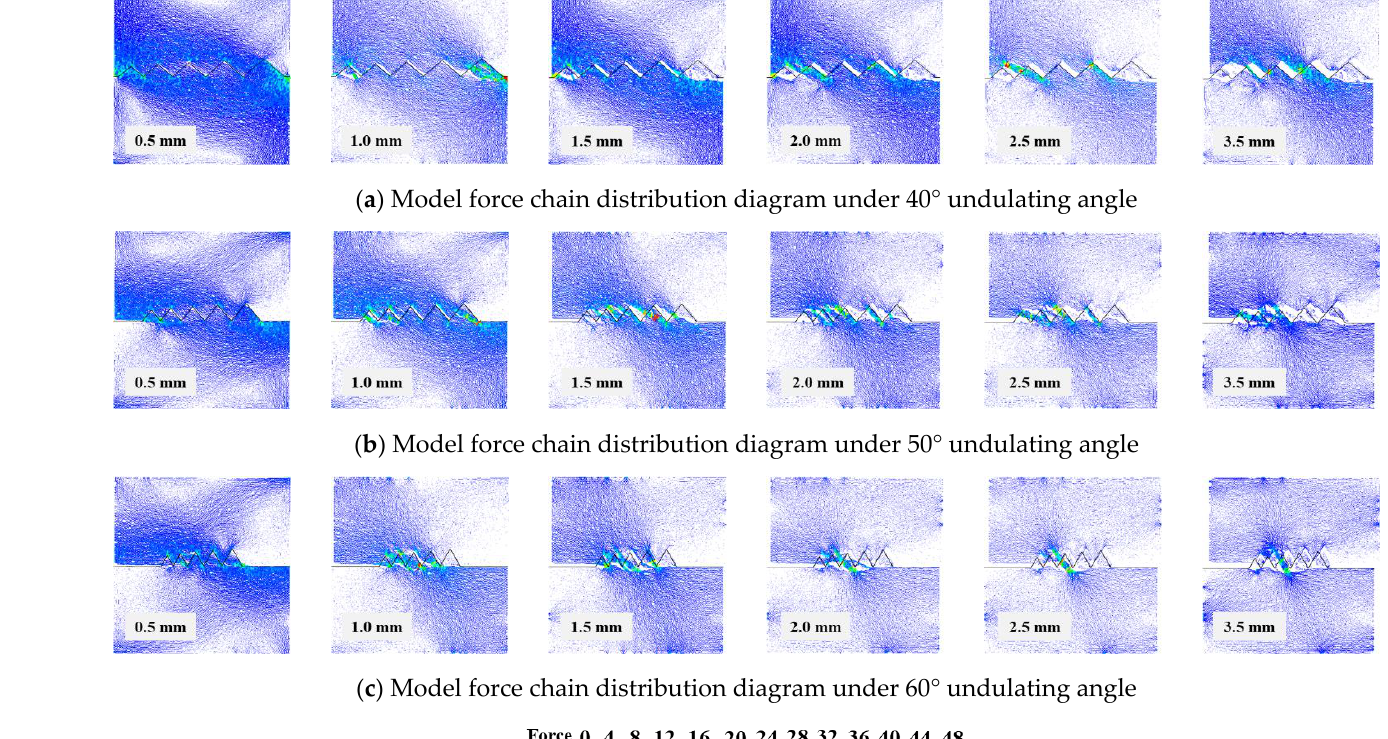
Figure 15. Model force chain distribution under different undulating angles.